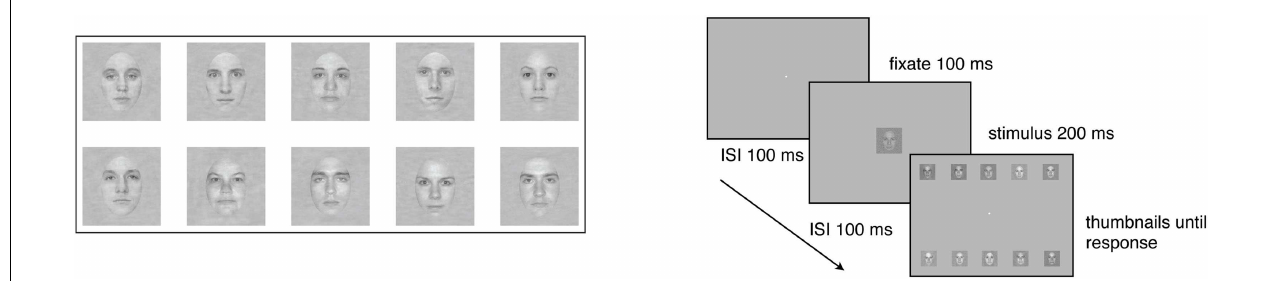
FIGURE 1 | Examples of stimuli used in the 10-AFC face identification tasks, and a schematic of the task.